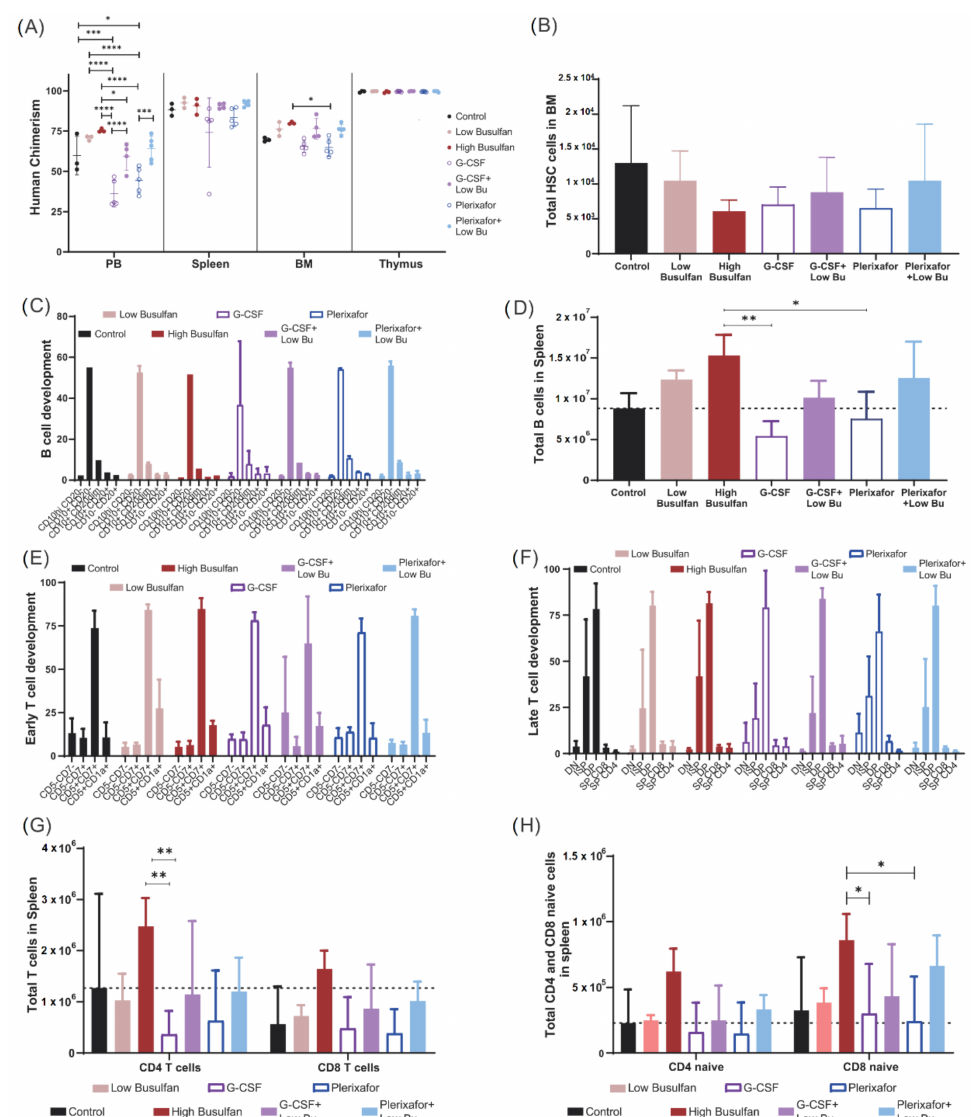
Figure 4. Long-term immune recovery after reduced busulfan conditioning. NSG mice (5 mice/group) were preconditioned with different conditioning regimens (low-dose busulfan, high busulfan, G-CSF, G-CSF+low-dose busulfan, plerixafor and plerixafor+low-dose busulfan) and transplanted with 100,000 CD34 enriched cells from cord blood. ( A ) Achieved human chimerism (% hCD45 cells) in PB, spleen, bone marrow (BM) and thymus 20 weeks after transplantation. (Two-way ANOVA; * p < 0.05, *** p < 0.001, **** p < 0.0001). ( B ) Total number of human hematopoietic stem cells (HCS) in NSG BM 20 weeks after transplantation. ( C ) Proportion of B-cell developmental stages in BM in the different conditioned regimen groups. ( D ) Total B cell counts in spleen 20 weeks after transplantation. (One-way ANOVA; * p < 0.05; ** p < 0.01). ( E , F ) Proportional T-cell developmental stages (early